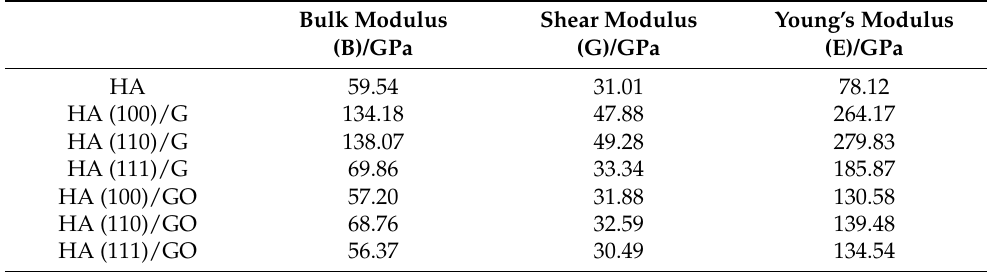
Table 2. Calculation results of three elastic modulus index values for each